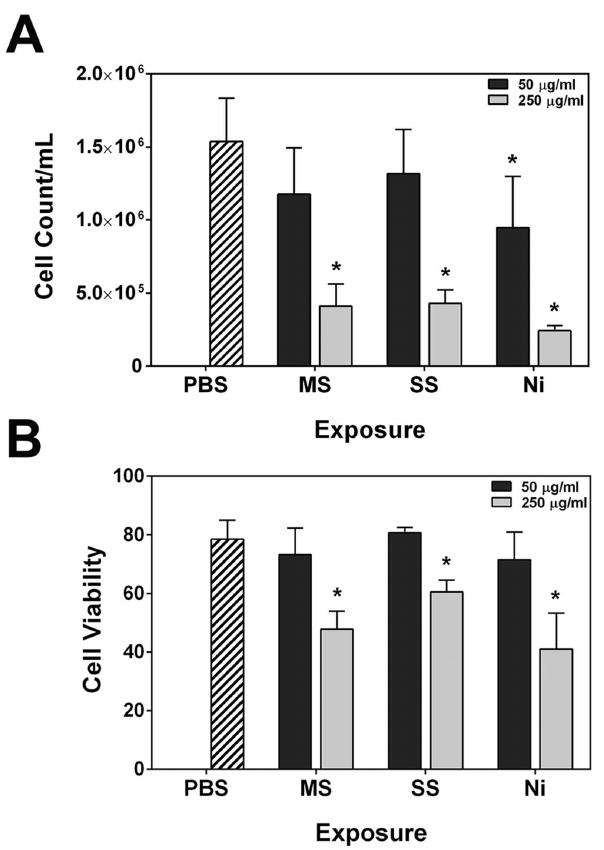
Figure 1. Welding fumes reduce RAW 264.7 cell viability. Cells were treated with suspensions of welding fumes for 24 h, washed twice with PBS, and cell counts were performed using trypan blue to determine the concentration of live cells ( A ) and percentage of viable cells ( B ) within each sample. Error bars represent the mean 6 SD (n=4). *, p , 0.05 compared to PBS control. MS; GMA-MS, SS; GMA-SS, Ni; Ni-Cu WF.